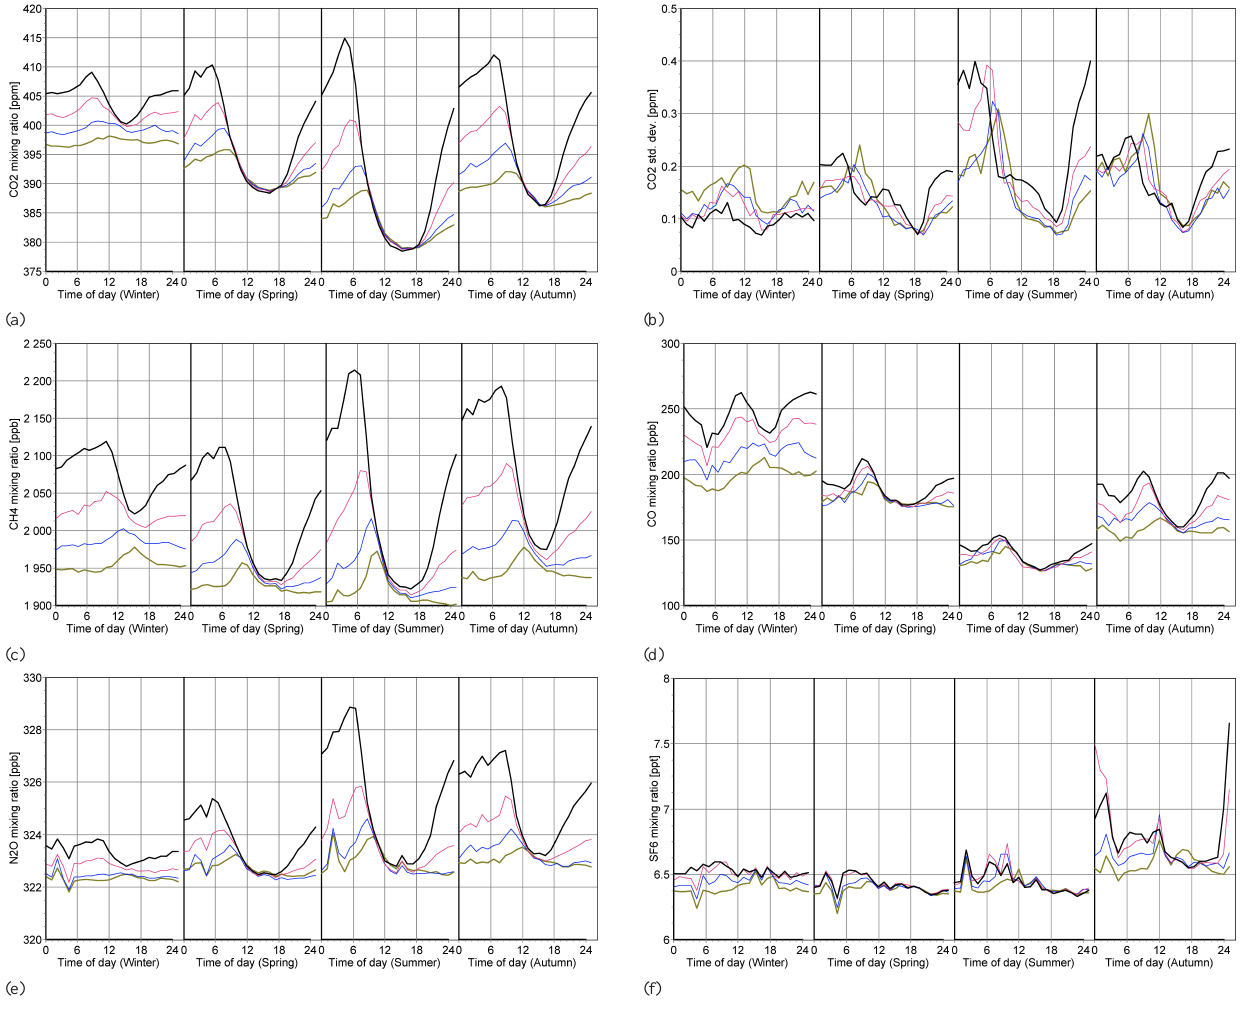
Fig. 11. Average diurnal vertical concentration profiles per season at Cabauw for the period 2005–2008 for: CO 2 (a) , CO 2 standard deviation (b) , CH 4 (c) , CO (d) , N 2 O (e) , and SF 6 (f) . Seasons are defined as Winter=Dec-Feb; Spring=Mar–May; Summer=Jun–Aug; Autumn=Sep–Nov. Colours as in Fig. 10.